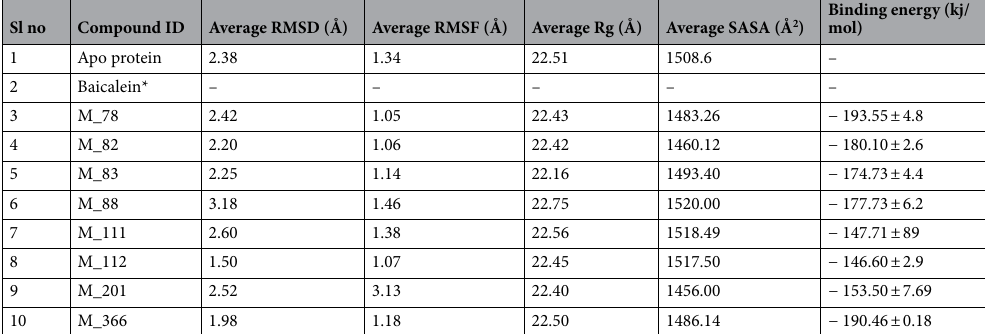
Table 3. Average values of Root Mean Square Deviation (RMSD), Root Mean Square Fluctuation (RMSF), Radius of Gyration (Rg), Solvent Accessible Surface Area (SASA), MM/PBSA based binding free energy calculated from 100 ns molecular dynamics trajectories. *Data available in Supplementary 81 .